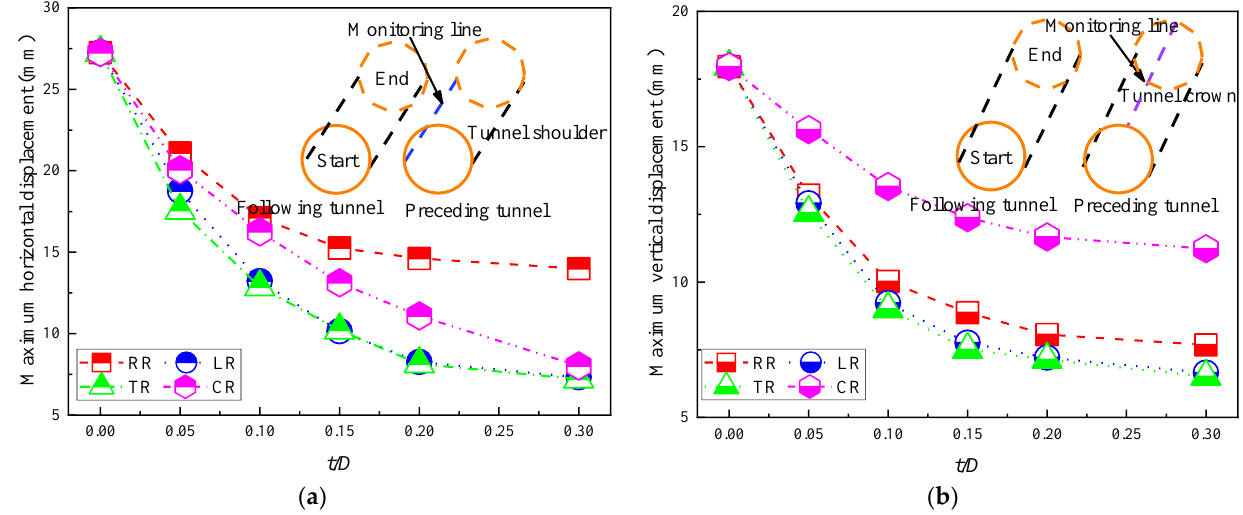
Figure 7. The maximum displacement of the preceding tunnel: ( a ) horizontal displacement; ( b ) vertical displacement.